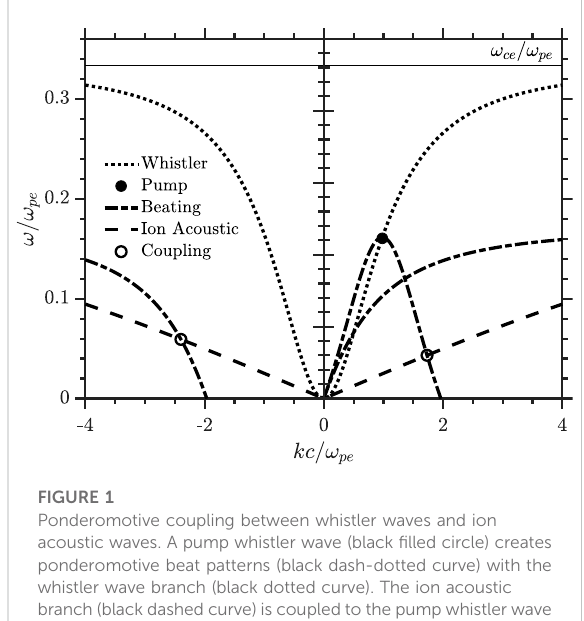
Ponderomotive coupling between whistler waves and ion acoustic waves. A pump whistler wave (black fi lled circle) creates ponderomotive beat patterns (black dash-dotted curve) with the whistler wave branch (black dotted curve). The ion acoustic branch (black dashed curve) is coupled to the pump whistler wave and whistler branch where it intersects with the pondermotive beating (black hollow circles). The solid black line indicates ω ce / ω pe